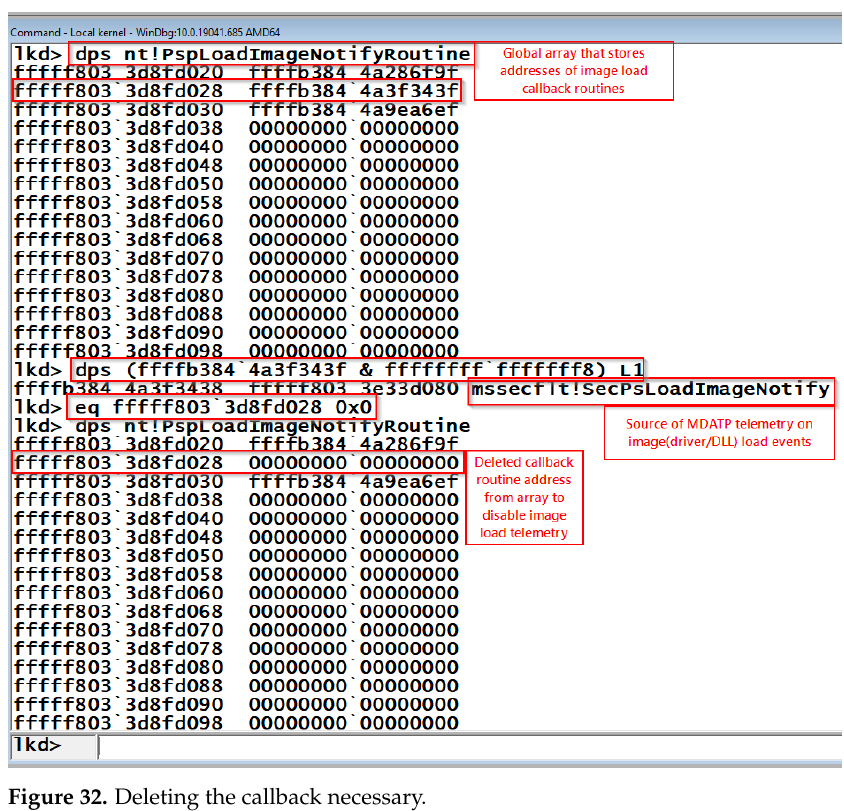
Figure 32. Deleting the callback necessary.